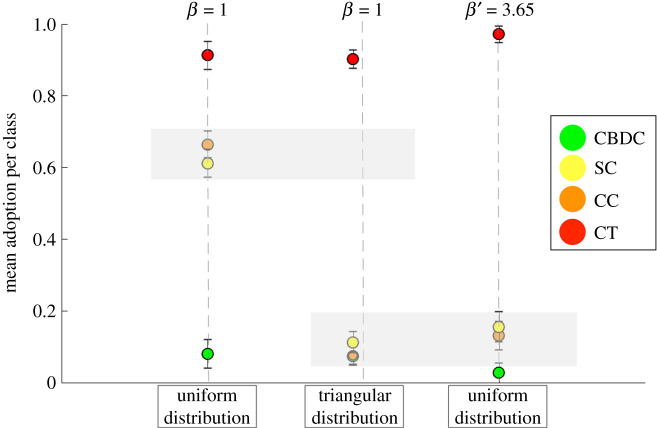
Mean (and variance) of the probability of not being adopted per asset class for the following scenario with N = 200 crypto assets, δ = 0.1 and (i) β = 1, π(s) = 1, π^(ξ)=1 (uniform pdf), (ii) β = 1, π(s) = 2 s, π^(ξ)=2ξ (triangular pdf) and (iii) β′ = 3.65, π(s) = 1, π^(ξ)=1 (uniform pdf rescaled). Legend—green, Central Bank Digital Currency (CBDC); orange, cryptocurrencies (CC); red, crypto tokens (CT); yellow, stablecoins (SC).